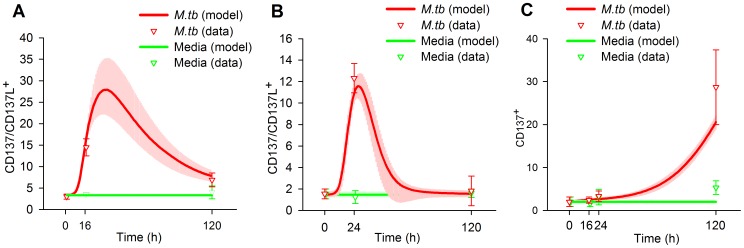
Fitting of the model (CD137/CD137L expression) to the data.A, Expression of CD137/CD137L in APC. B, Expression of CD137/CD137L on NK. C, Expression of CD137 on TL. Curves represent the best fit of our mathematical model to the data. The median and the 50% of the predictive posterior interval are shown. Means of experimental data are shown by triangles, error bars indicate the SEM from each group (7 individuals). Experimental data were obtained from PBMC of tuberculosis patients stimulated with M.tb Ag for 0, 16 and 120 h (A), 0, 24 and 120 h (B) or 0, 16, 24 and 120 h (C). CD137 expression was determined by flow cytometry. The cytometric analysis was performed by first gating on monocytes by light scatter and then gating on CD14+ cells (A), or by first gating on lymphocytes by light scatter and then on CD3−CD56bright for NK cells (B) or on CD3+ for T lymphocytes (C). Predictions were made according to the following equations (Supporting Information S1): A: R4, B: R8, C: R10.